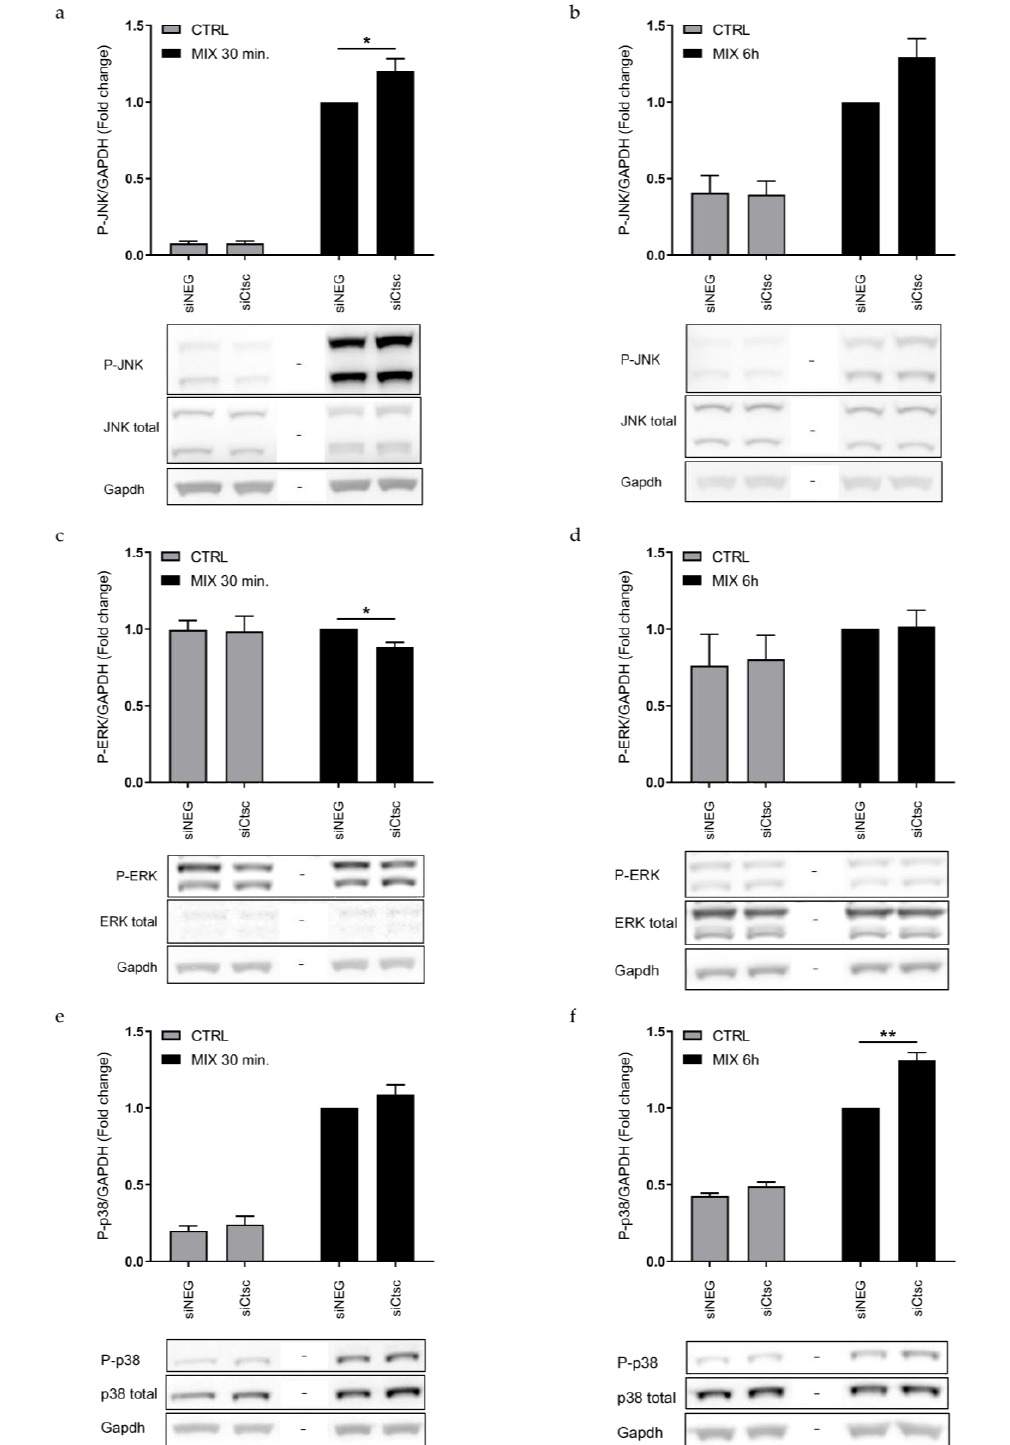
Figure 4. Knockdown of Ctsc regulates MAPK signaling. INS-1E cells were transfected with siRNA against Ctsc (siCtsc) or a non-targeting negative control siRNA (siNEG) and were then left untreated (CTRL) or exposed to IL-1 β and IFN- γ (MIX) for 30 min or 6 h. Immunoblotting of phosphorylated JNK after ( a ) 30 min and ( b ) 6 h, phosphorylated ERK after ( c ) 30 min and ( d ) 6 h, and phosphorylated p38 after ( e ) 30 min and ( f ) 6 h. Gapdh was used as loading control. Data are presented as fold changes with mean ± SEM ( n = 4–7). *: p < 0.05; **: p <